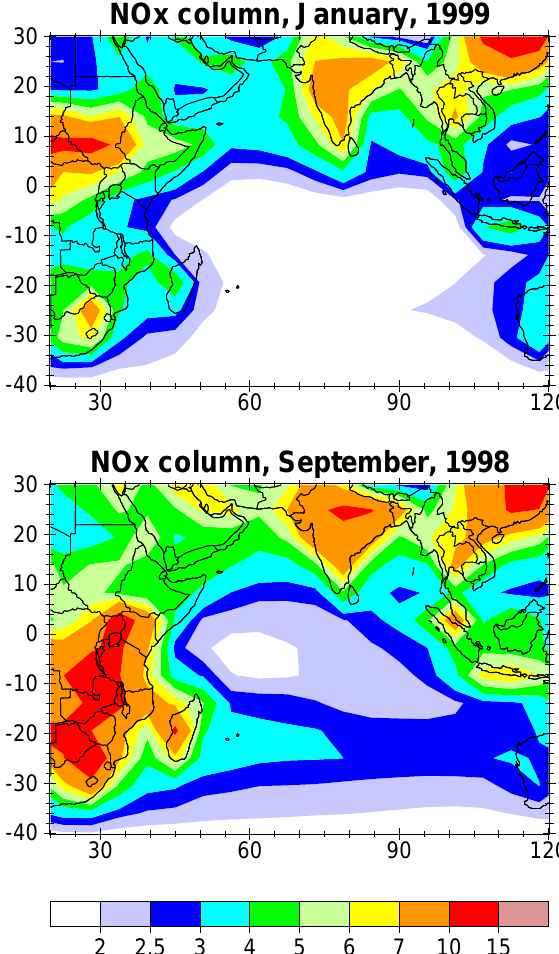
Fig. 52. Horizontal structure of the tropospheric NO x column (in 10 14 molecules/cm 2 ) from the MATCH-MPIC model. Top: Jan- uary 1999, during INDOEX; bottom: September 1998, during the monsoon transition period (based on data from simulations dis- cussed in Kunhikrishnan et al.,